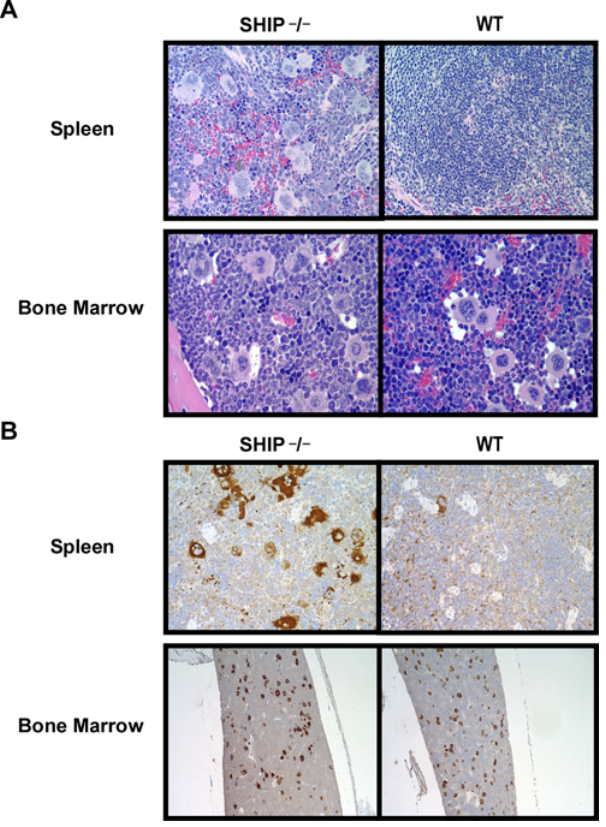
Figure 1. MK morphology and Glycoprotein IIB-IIIa (CD41) immunostain in BM and spleen of SHIP deficient mice. (A). Hematoxylin-Eosin staining of BM and spleen of SHIP 2 / 2 ( 2 / 2 ) and wild type (WT) littermate controls. Spleen of SHIP deficient mice is characterized by a massive infiltrate with morphologically appearing MK (left panel) compared to WT littermates (right panel). BM of SHIP 2 / 2 mice contained hypolobulated micro-MK compared to hyperlobulated MK in WT BM. Magnification: 6 60. Results are representative of those obtained in 3 animals per experimental group (B). Glycoprotein IIB-IIIA (CD41) immuno-histochemistry. Spleen of SHIP 2 / 2 mice contained a higher percentage of CD41 + cells compared to WT spleen. Magnifica- tion: 6 40. BM of SHIP deficient mice contained comparable number of CD41 + cells compared to WT. Magnification: 6 60.